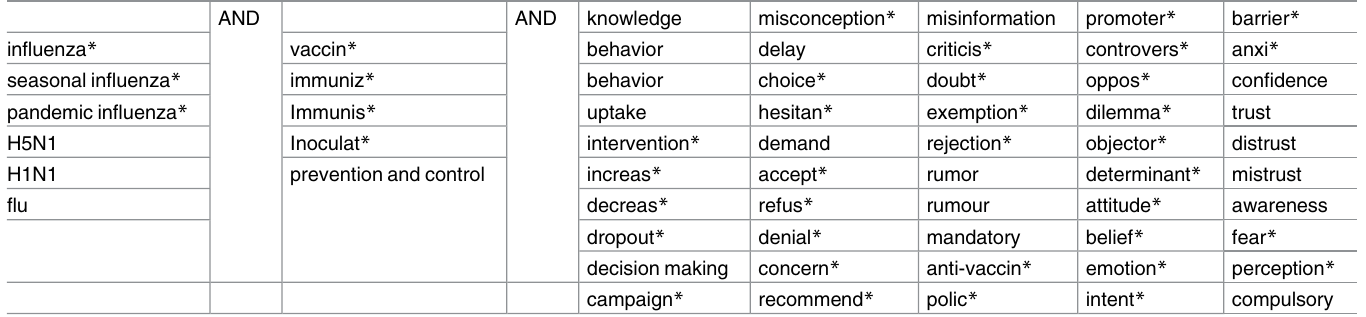
Table 1. Keywords used for the literature search.